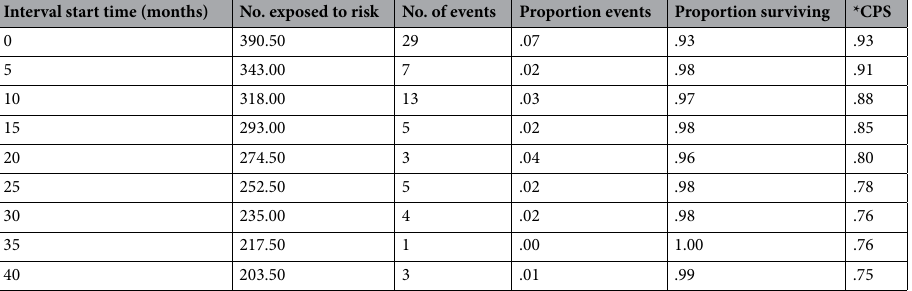
Table 3. The overall life table of adult patients co-infected with TB, and HIV on ART follow-up at Mettu Karl Referral Hospital, Ethiopia, 2014–2022 (n = 402). Source : MKRH from 1st February 2014 to 30th January 2022, CPS: Cumulative Proportion Surviving at End of